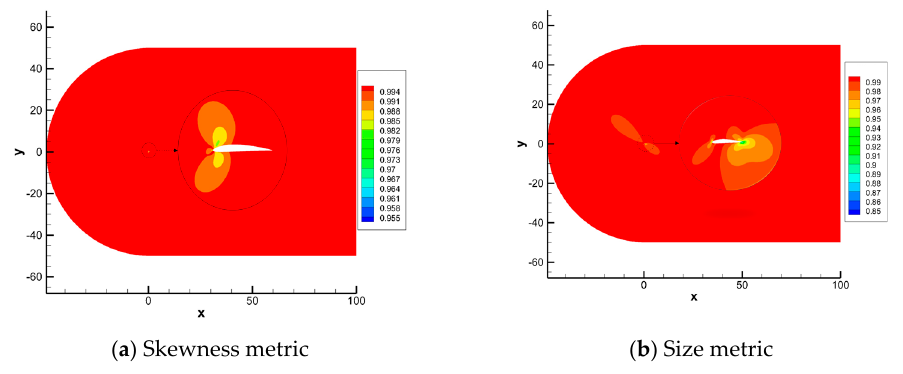
Figure 16. Mapping-based metrics in test case 3.